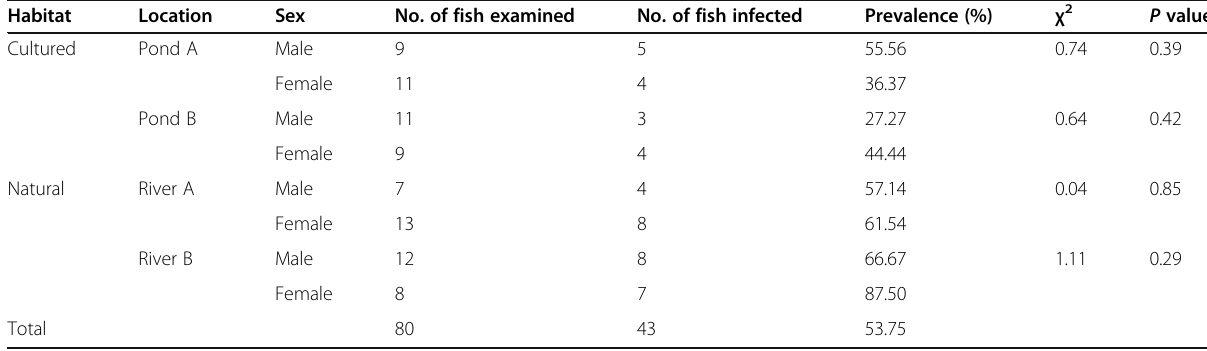
Table 5 Prevalence of parasites in relation to the sex of C. gariepinus Habitat Location Sex No. of fish examined No. of fish infected